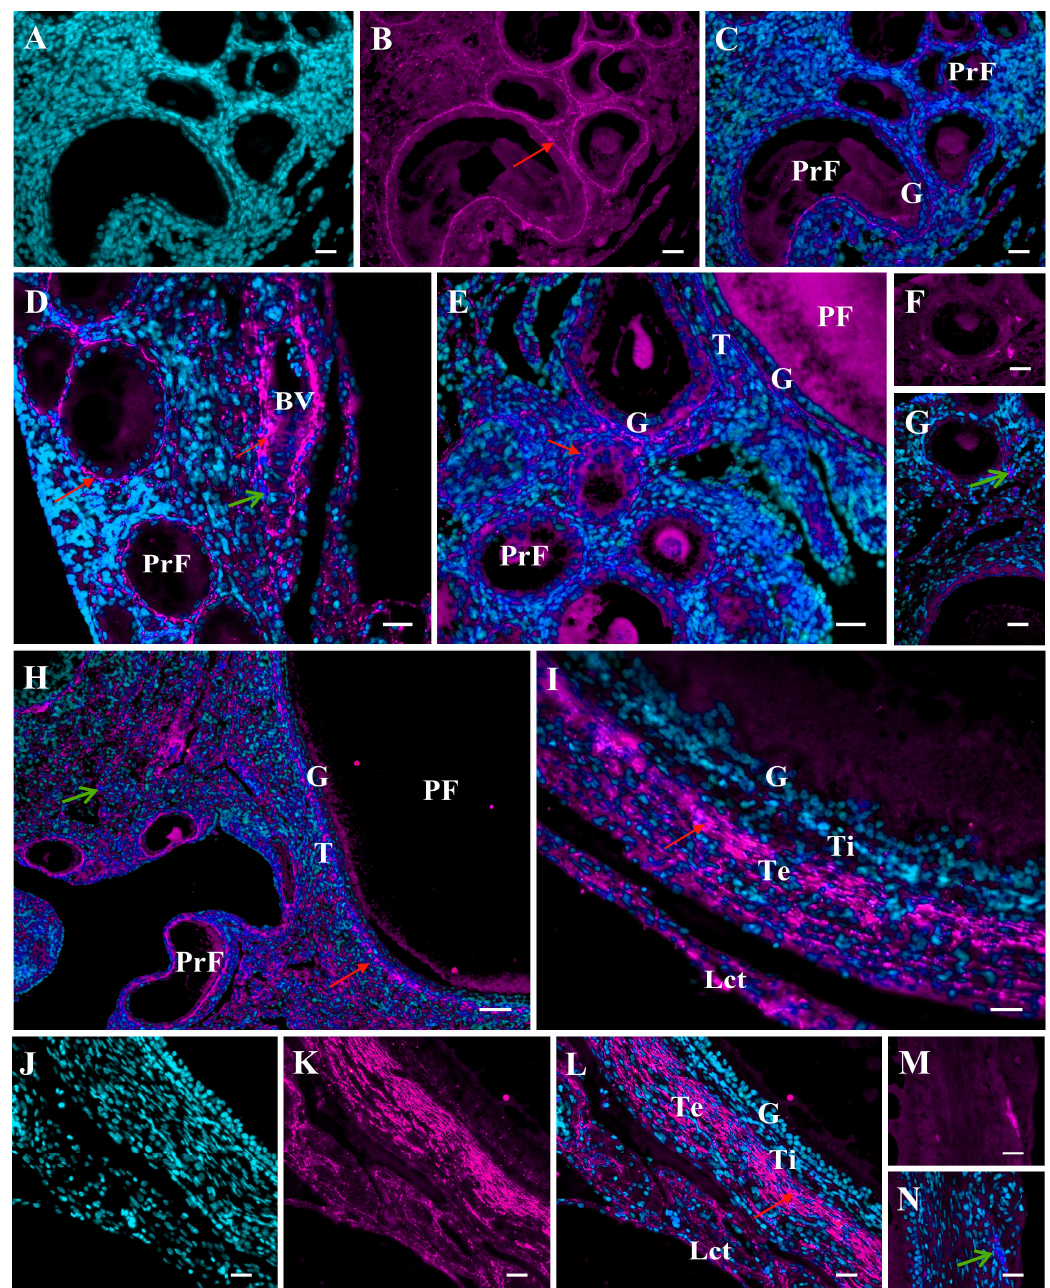
Figure 3. Immunofluorescent localization of the MMP-9 protein in the ovary of growing chickens. Representative micrographs of the chicken ovary obtained about six weeks ( A – C , F , G ), four weeks ( D ), and two weeks ( E ) before sexual maturation and of the ovarian stroma obtained from a mature hen ( H ). The wall of the white follicle ( I ) and the yellowish follicle ( J – N ) obtained from the ovary about four and two weeks before maturation, respectively. Positive fluorescence for MMP-9 (magenta; red arrows) presents extracellularly in the ovarian stroma, in the basal lamina surrounding primordial follicles (PrF), in the basal lamina and theca of primary follicles (PF), and primarily in the theca externa of white and yellowish follicles as well as around blood vessels (BV). Negative control sections incubated without the primary antibody (Abcam, Cambridge, UK) do not exhibit positive staining ( F , G , M , N ). DAPI staining (cyan) of the cell nuclei only ( A , J ). Specific immunoreactivity for MMP-9 ( B , K ). Merger of DAPI and MMP-9 ( C – E , G – I , L , N ). Other explanations and abbreviations as in Figure